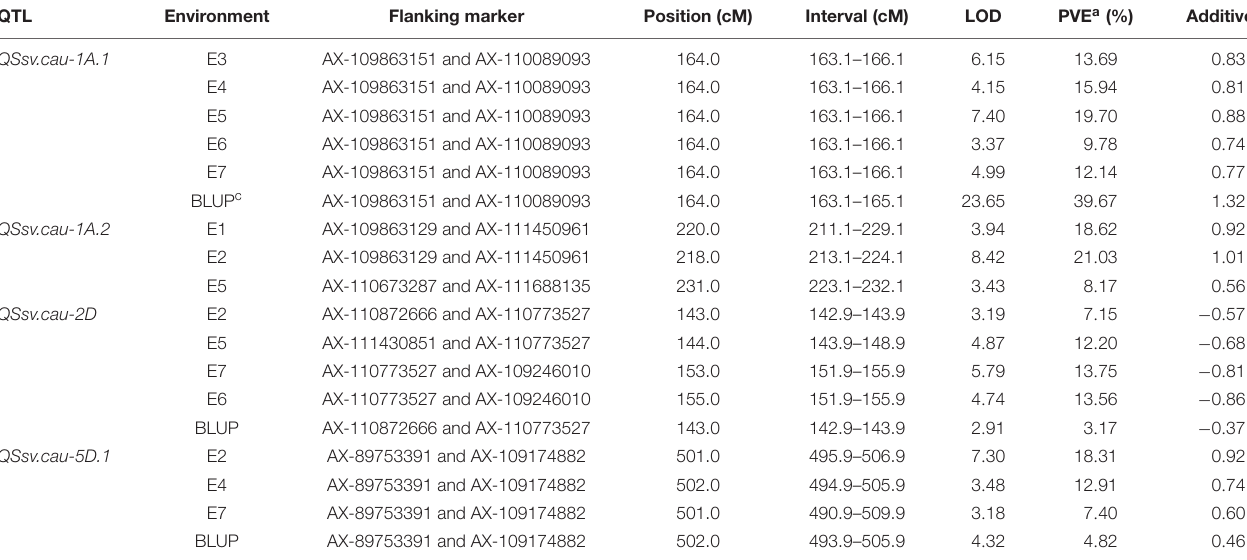
TABLE 3 | The QTL regions harboring environmentally stable QTLs for SSV in the ND3753/LX99 DH